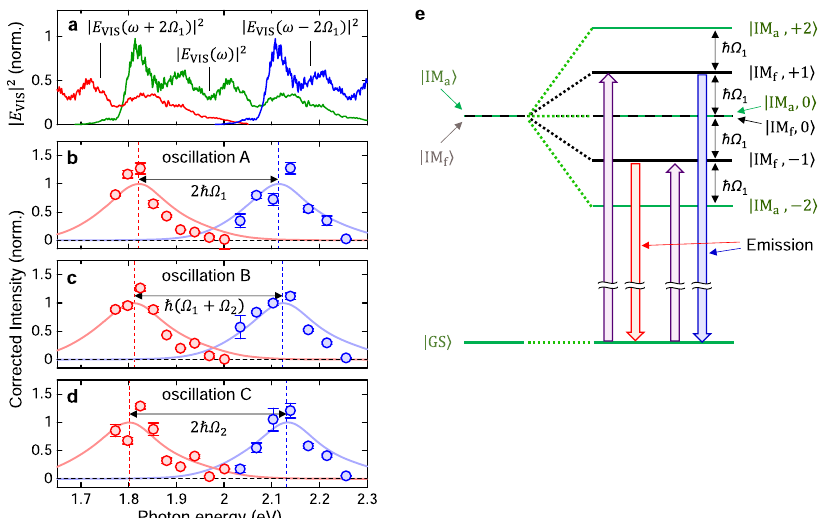
Fig. 5 Probe photon-energy dependence of high-frequency oscillations in optical responses associated with phonon-dressed states in K-TCNQ. a The (cid:7) (cid:7) (cid:7) (cid:7) 2 and those shifted by power spectrum of the visible-probe pulse E VIS ω ð Þ ± 2 Ω 1 . b – d The corrected intensities of high-frequency oscillations A – C ð ω Þj 2 ( b ), expressed by Eq. (6) for _ ω > 2 eV (blue circles) and for _ ω (cid:6) 2 eV (red circles). Blue and red lines show simulated spectra of j χ ð 3 Þ ± Ω 1 ; ± Ω 1 j χ ð 3 Þ ð ω Þj 2 ( c ), and j χ ð 3 Þ ð ω Þj 2 ( d ) based upon the three-level model, which correspond to the intensity spectra for oscillations A, B, and C, ± Ω 1 ; ± Ω 2 ± Ω 2 ; ± Ω 2 ð ω Þ (oscillation A). The respectively. The error bars indicate the standard deviation of the least-squares fi t. e The optical process corresponding to χ 3 ð Þ ± Ω 1 ; ± Ω 1 probe pulse produces a transition from the ground state |GS 〉 to the (cid:5) 1-phonon-dressed state, |IM f , ∓ 1 〉 , and the light emission associated with a transition from |IM f , ± 1 〉 to |GS 〉 occurs. It generates the oscillatory component whose frequency equals twice the frequency of the